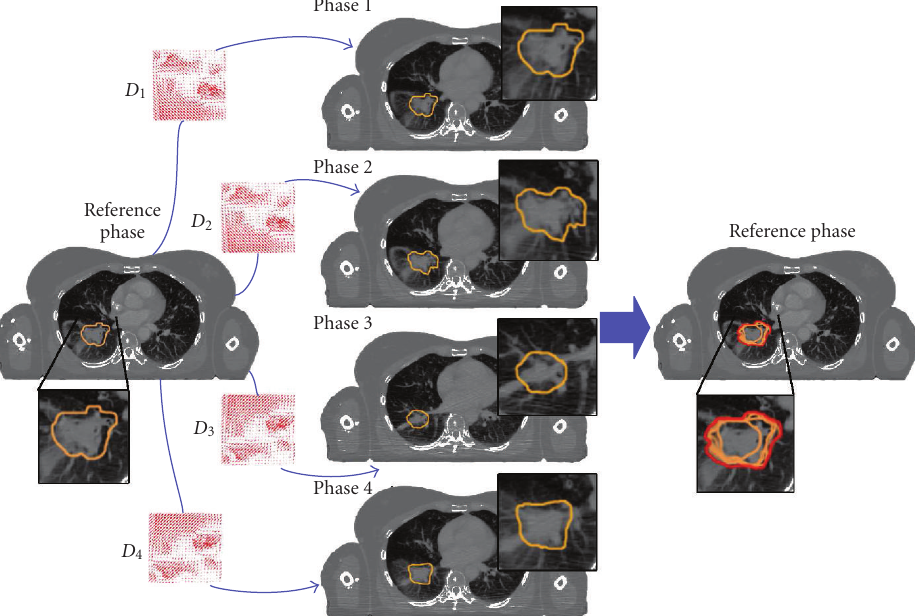
Figure 7: Schematic representation of the ITV creation (with only 4 phases). The CTV delineated on a reference image with contrast enhancement (on the left) is deformed towards every phases (middle) using displacement fields estimated by registration, and their union is taken as ITV (on the